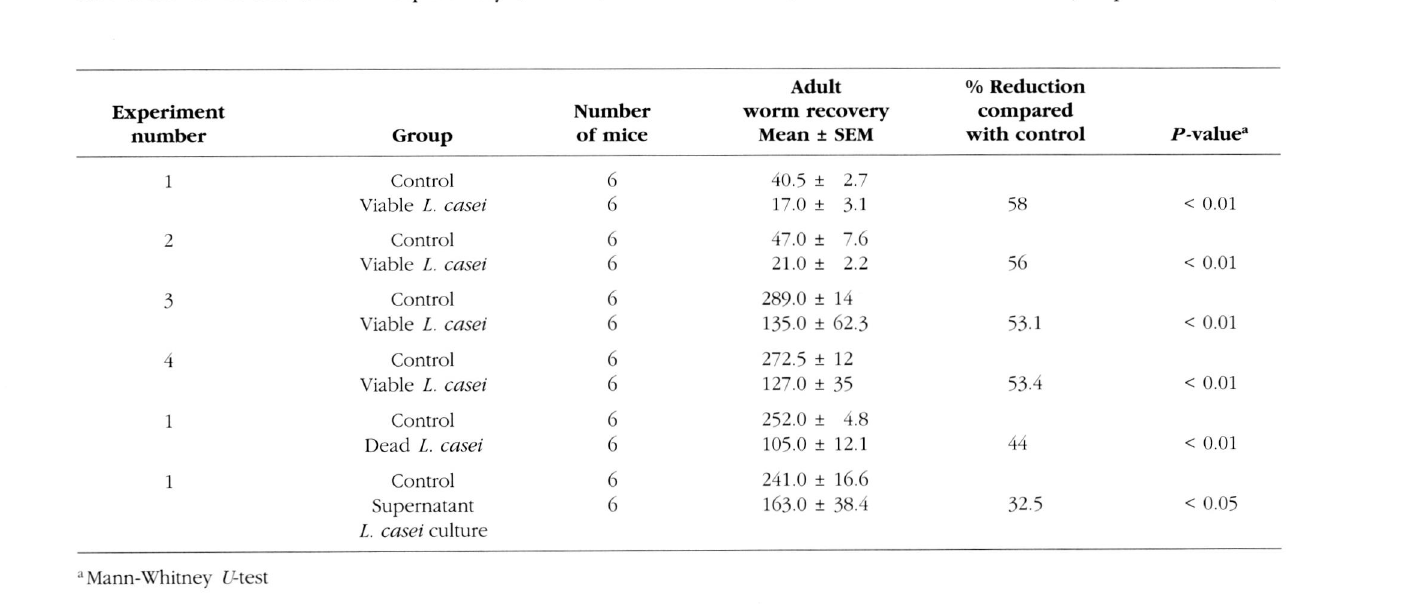
Table I. — Effect of Lactobacillus casei oral treatment on the number of adult worms recovered from NIH mice, five days after the Trichi nella spiralis challenge. Parasite, 2001, 8,